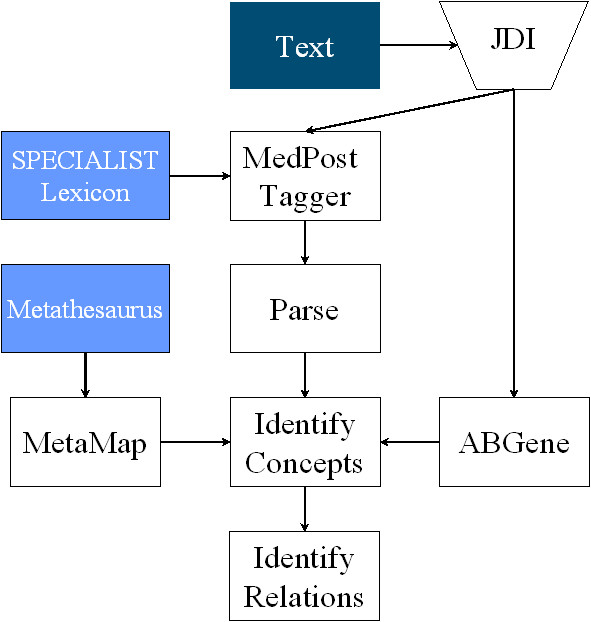
SemGen components and workflow. JDI: Journal Descriptor Index.